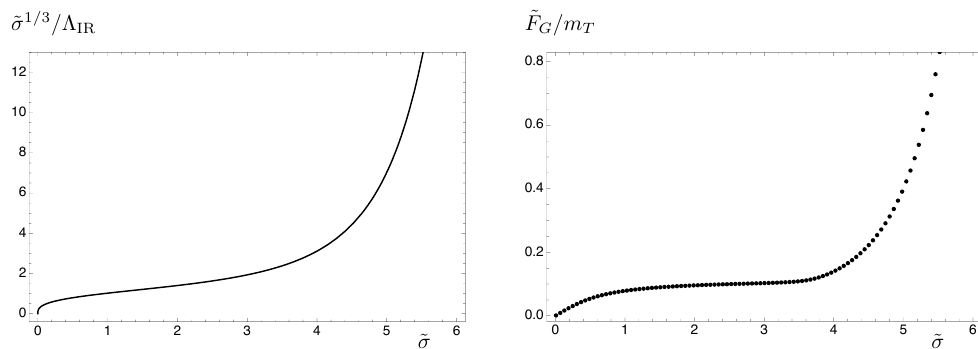
Figure 1 . Example A. The dimensionless ratio ˜ σ 1 / 3 / Λ IR (left panel) and the decay constant (right panel) as a function of ˜ σ for ∆ = 3 , g decay constant.